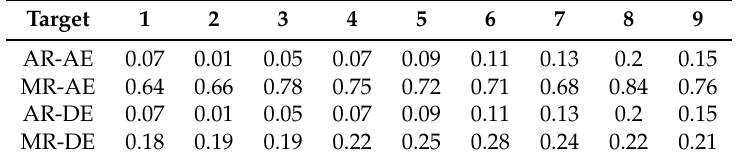
Table 1. Automatic Registration Average Error (AR-AE), Standard Deviation Error (AR-DE) and Manual Registration Average Error (MR-AE), Standard Deviation Error